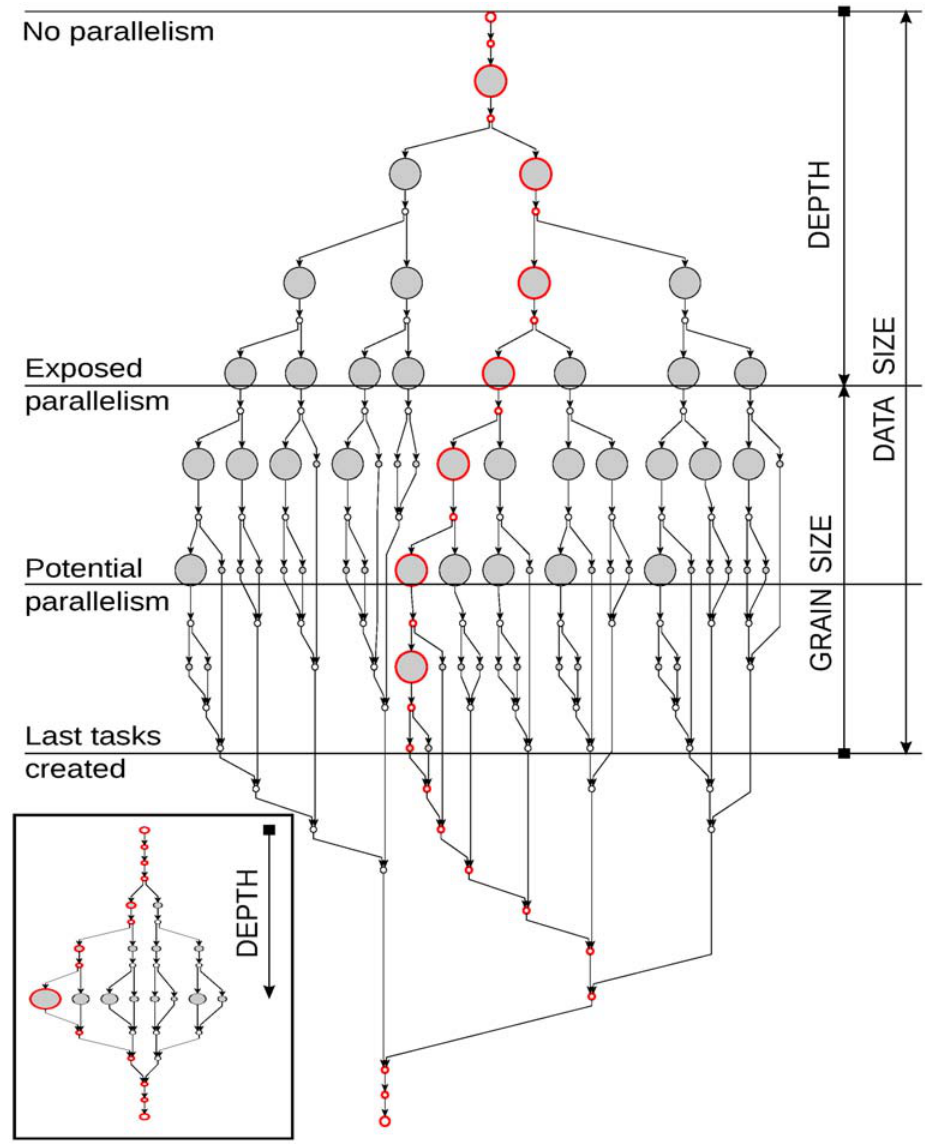
Fig 4. Task graph of Fibonacci. Large graph: input n = 8, depth cutoff = 1 . Small graph in inset: input n = 8, depth cutoff = 3. Size of task nodes (gray) indicates instruction count. Critical path is marked by nodes with a red border.